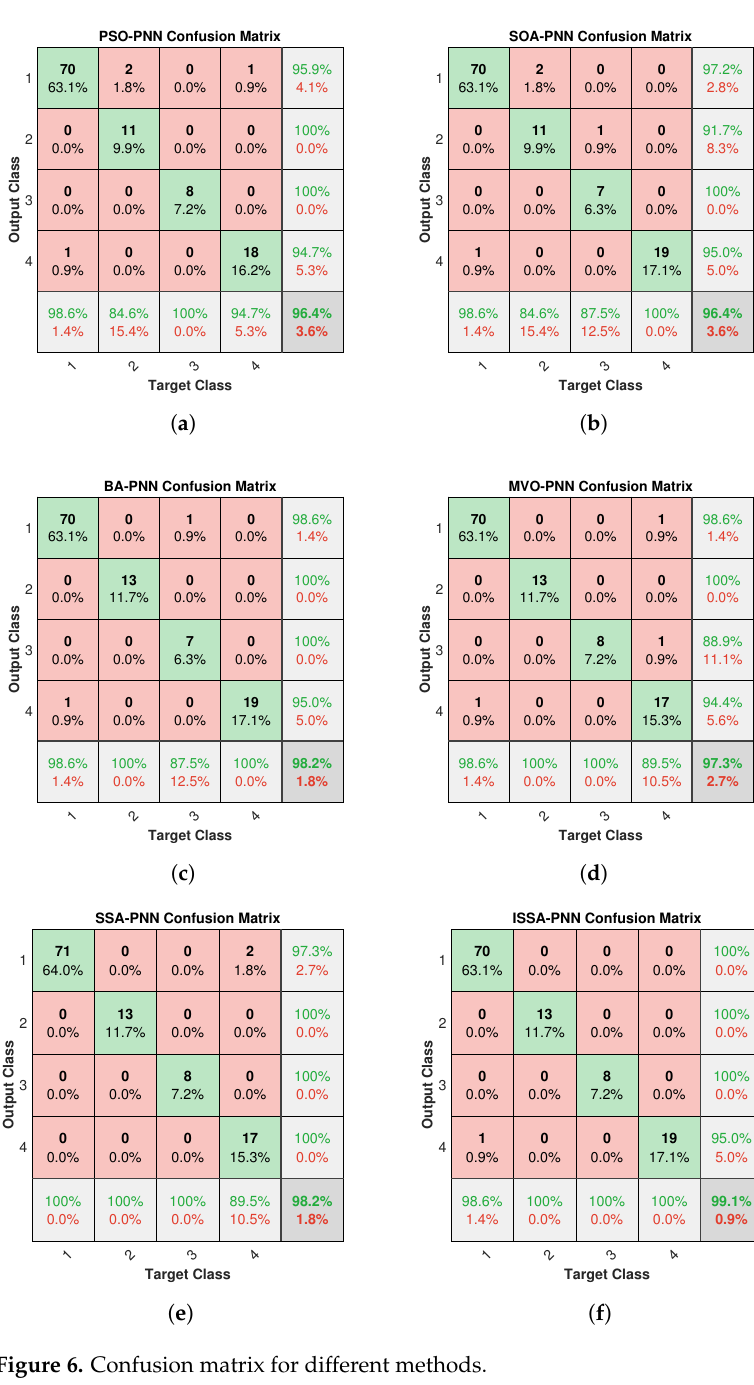
Figure 6. Confusion matrix for different methods.